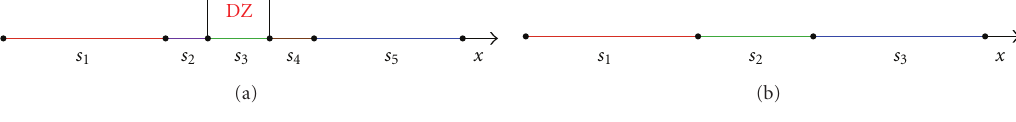
Figure 5: Basic dynamics for (a) tacking and (b) wearing.